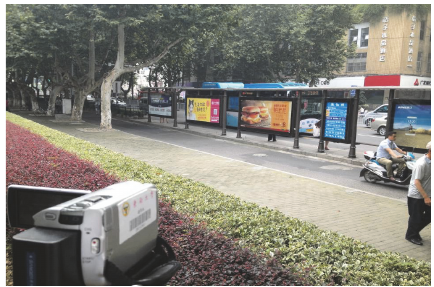
Figure 2: Field data collection.